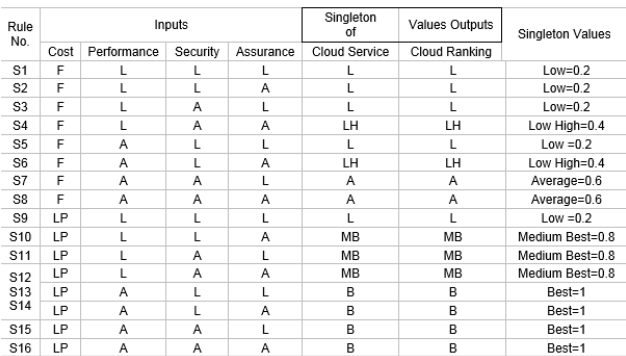
Table 9. Singleton Values of Proposed AFIS